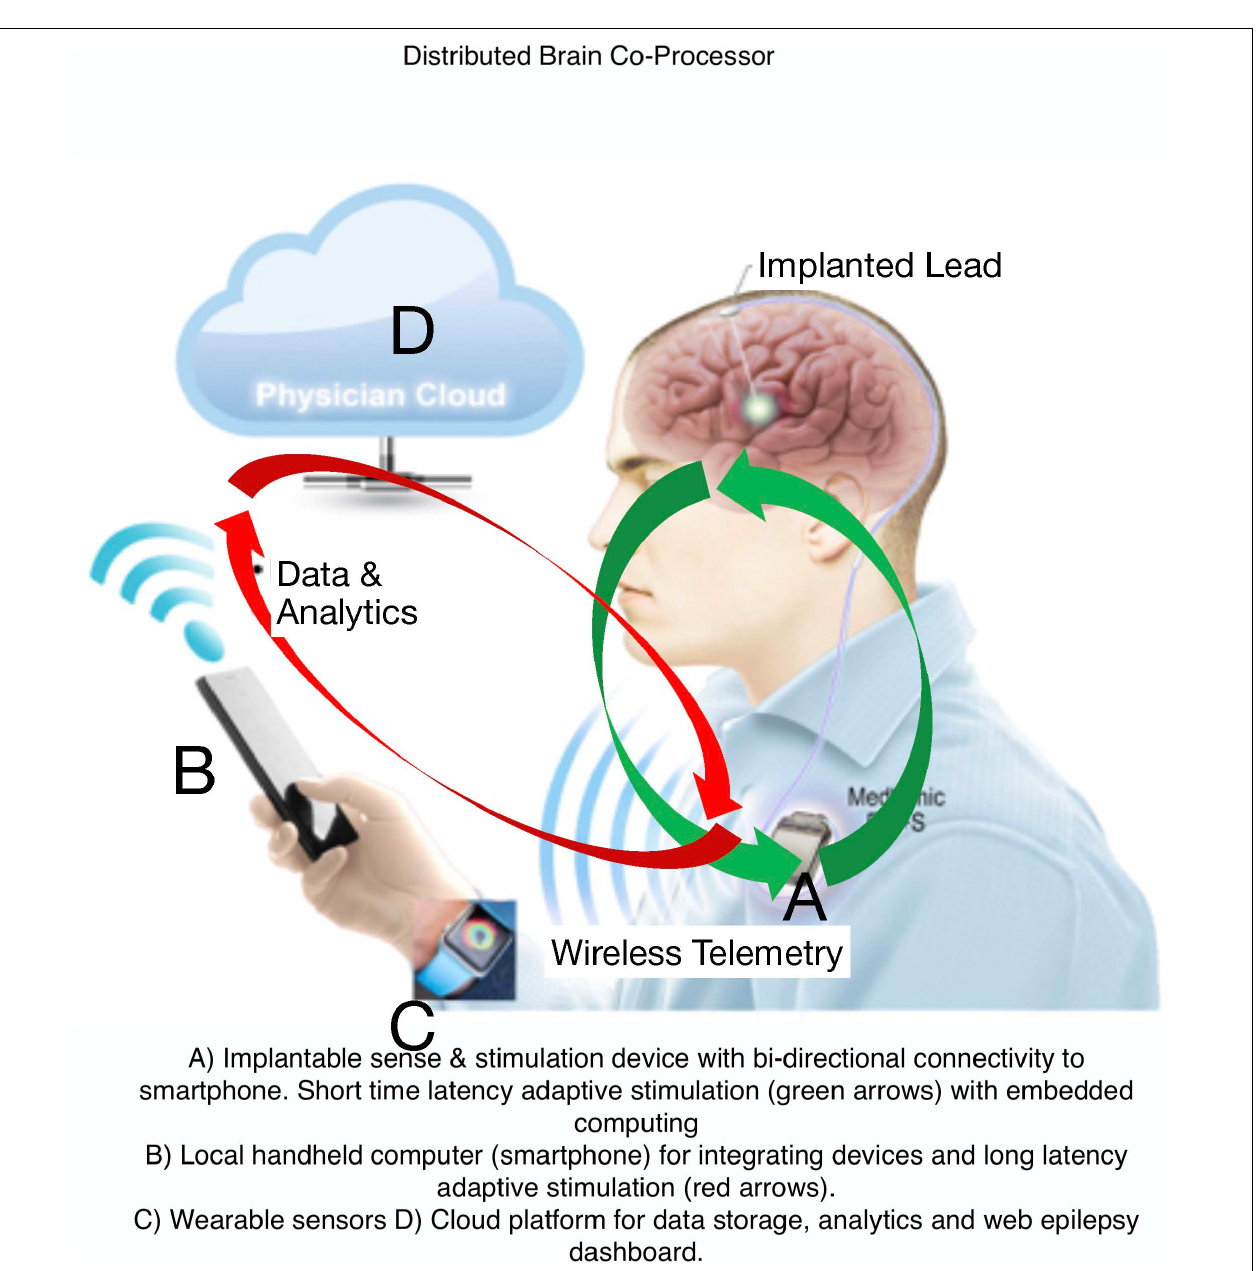
FIGURE 7 | Digital Platform for Neurological and Psychiatric Disease. Integration of brain implants, smart phones, wearable sensors, and computing environments that provide data analytics synchronized with biomarker or user triggered interactions that can enable new therapy paradigms.